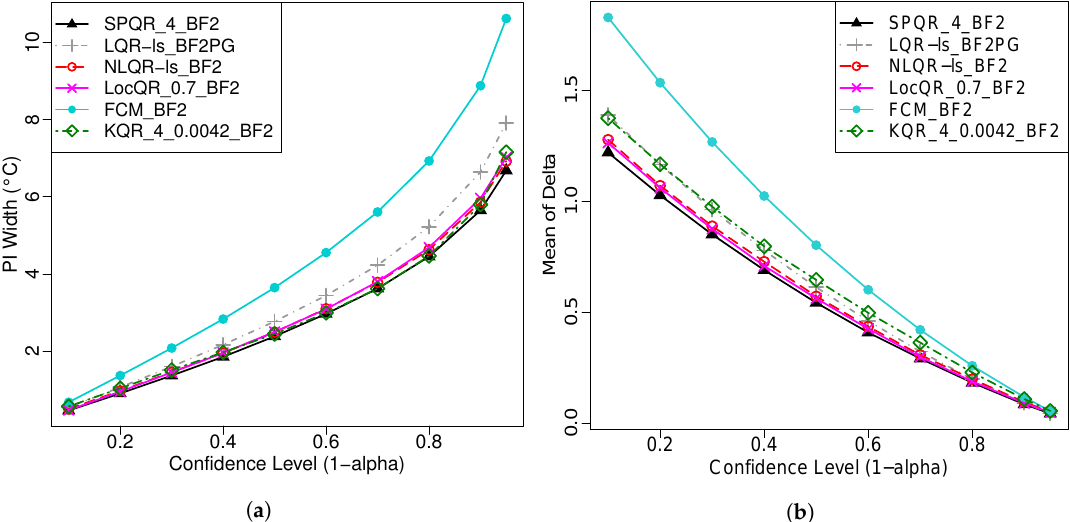
Figure 9. Comparison of prediction interval width and ¯ ∆ α between various methods over confidence levels. ( a ) Prediction interval width; ( b ) ¯ ∆ α